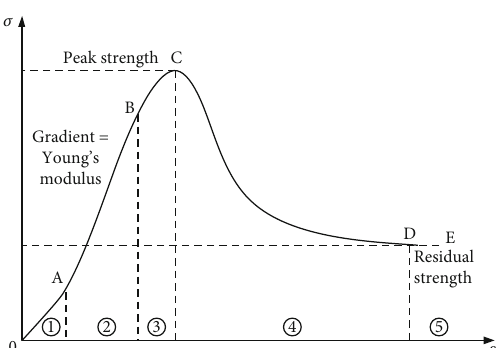
Figure 1: Schematic diagram of the entire stress – strain curve of rock in the